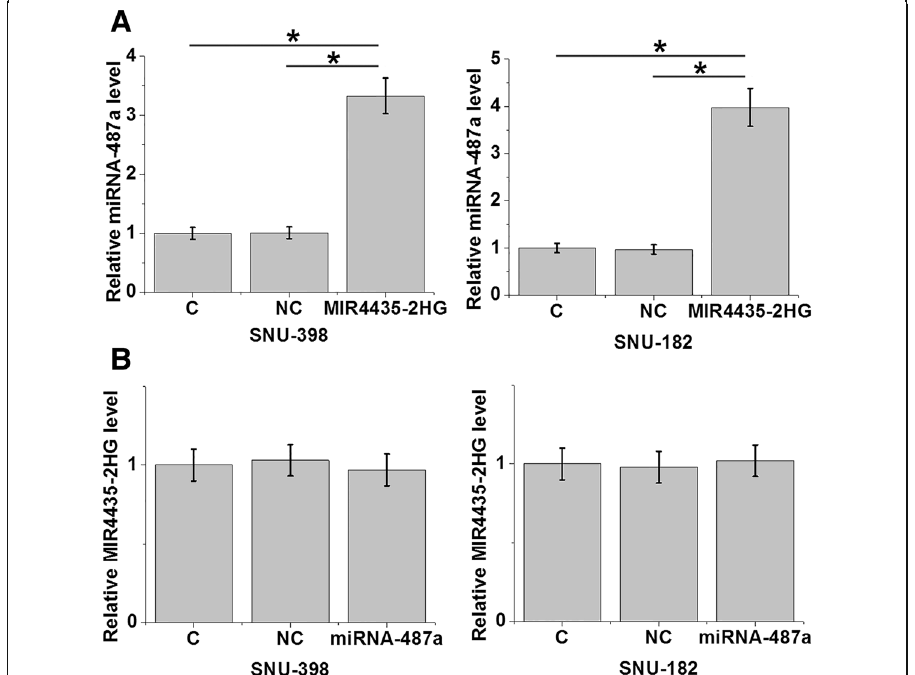
Fig. 4 Overexpression of MIR4435-2HG led to upregulation of miRNA-487a in the cells of HCC cell lines. a – Overexpression of lncRNA MIR4435-2HG mediated the inhibited expression of miRNA-487a in cells of the HCC cell lines SNU-398 and SNU-182. b – overexpression of miRNA-487a did not significantly affect lncRNA MIR4435-2HG. * p <